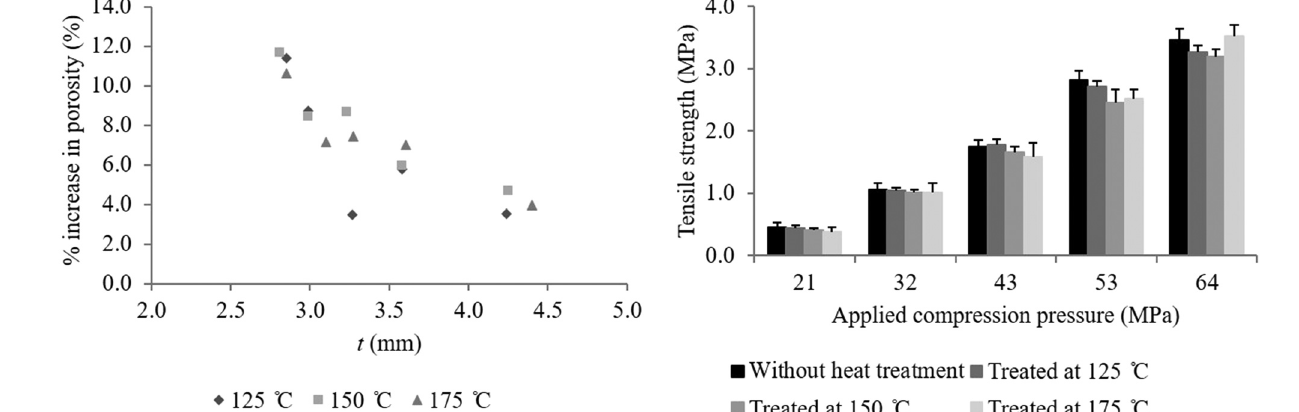
Figure 5: Comparisons between the averages of the tensile strengths of compacts without heat treatment and compacts heat treated at 125°C, 150°C, and 175°C prepared at various applied compression pressures. Error bars represent + standard deviation, n =